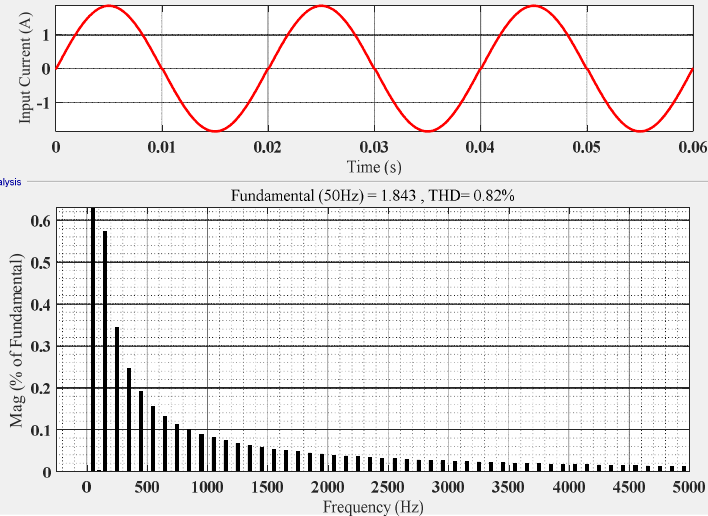
Figure 7. Simulated waveforms: ( a ) input voltage ( v s ); ( b ) output voltage ( v o ); ( c ) input current ( i s ); ( d ) output current ( i o ).